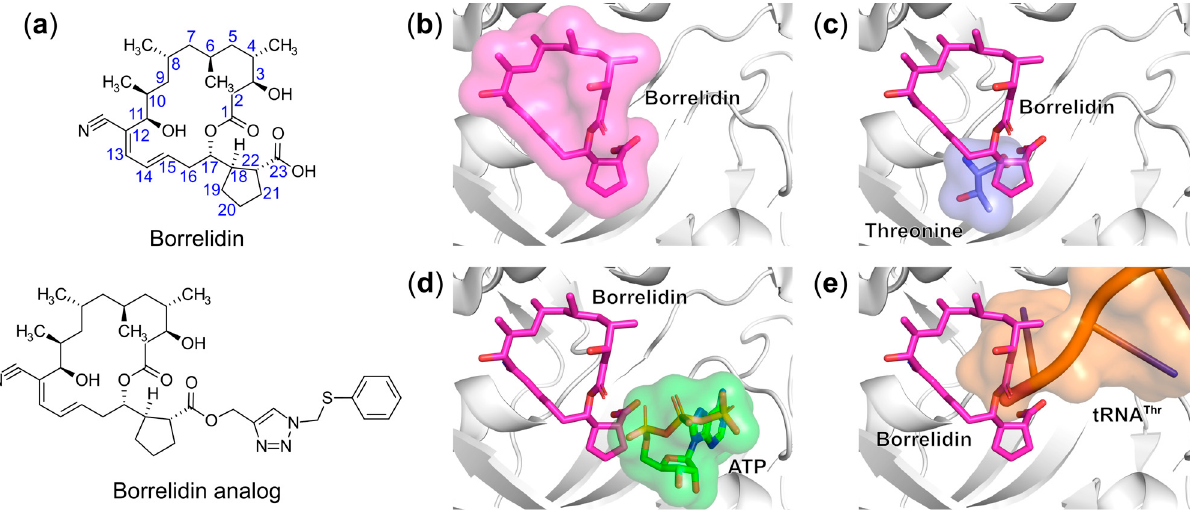
Figure 11. Structures of inhibitors targeting ThrRS. ( a ) Chemical structures of borrelidin and its analog. ( b ) Crystal structure of E. coli ThrRS in complex with borrelidin (PDB entry: 4P3P). The protein backbone is shown as a cartoon representation (grey) while borrelidin is shown as sticks (magenta C-atoms) covered by a semi-transparent molecular surface. ( c ) Threonine binding site of superimposed E. coli ThrRS-borrelidin with ThrRS-threonine (PDB entry: 1EVK) structures. Threonine is shown as a stick model (slate C-atoms) covered by a semi-transparent surface. ( d ) ATP binding site of superimposed E. coli ThrRS-borrelidin with S. aureus ThrRS-ATP (PDB entry: 1NYR) structures. ATP is shown as a stick representation (green C-atoms) covered by a semi-transparent molecular surface. ( e ) The tRNA Thr binding site of superimposed E. coli ThrRS-borrelidin with ThrRS-tRNA Thr (PDB entry: 1QF6) structures. The tRNA Thr is shown as an orange cartoon diagram covered by a semi-transparent molecular